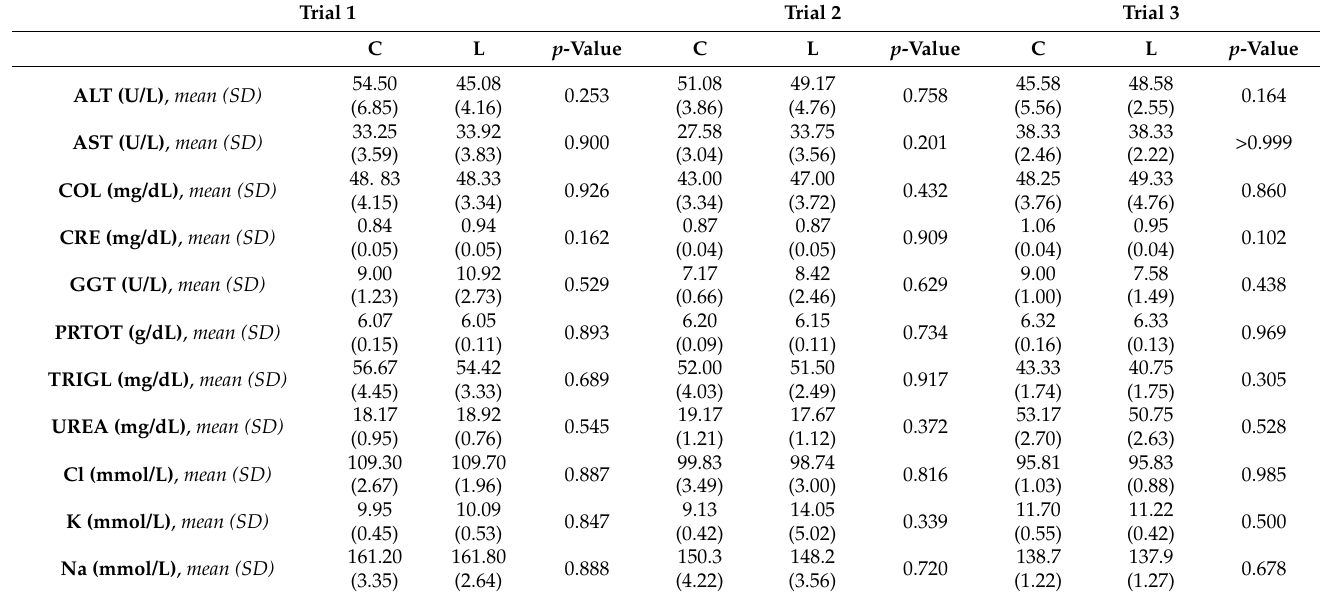
Table 3. Clinical chemistry analysis between control and probiotic group of trial 1, 2 and 3. Trial 1 Trial 2 Trial 3